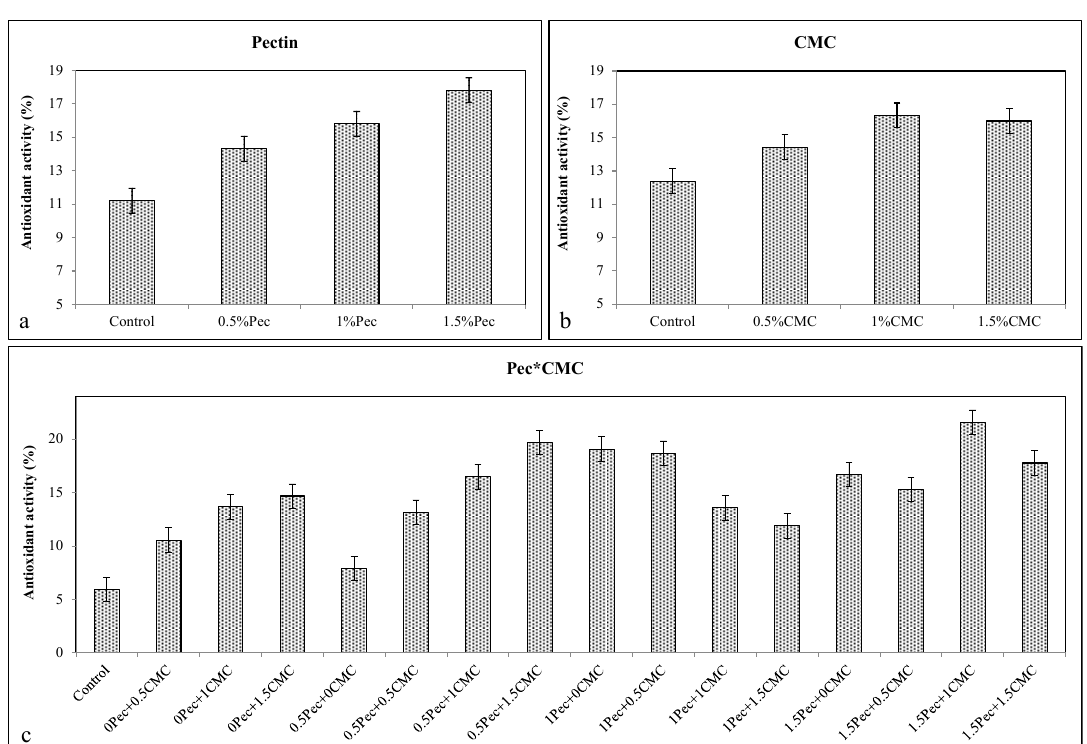
Figure 9. Effect of 0 (control), 0.5 (0.5% Pec), 1 (1% Pec) and 1.5 (1.5% Pec) % pectin-based edible coatings ( a ), 0 (control), 0.5 (0.5% CMC), 1 (1% CMC) and 1.5 (1.5% CMC) % carboxymethylcellulose-based edible coatings ( b ) and their combinations ( c ) on antioxidant activity based on the 1,1-Diphenyl-2-picryl-hydrazyl hydrate (DPPH) method during cold storage period. Data are the “estimated marginal means ± 95% confidence intervals”. The columns with non-overlapping error bars are significantly different ( p ≤ 0.05).